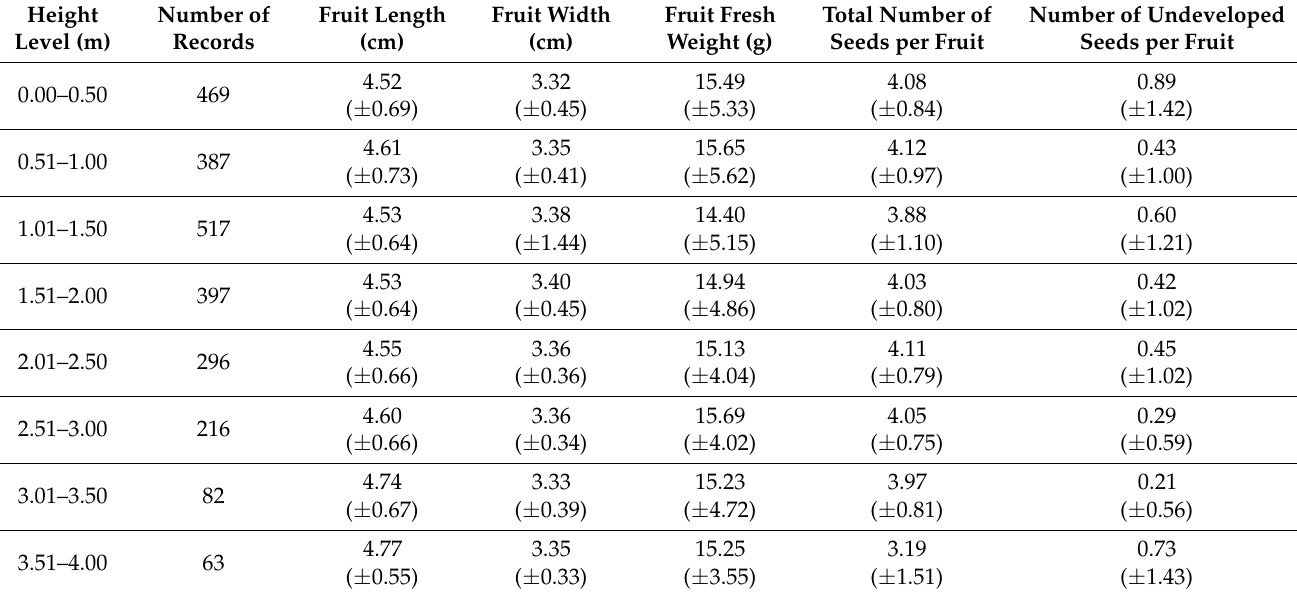
Table 3. The fruit and seed traits (mean ± SD) of Echinocystis lobata at different height levels.